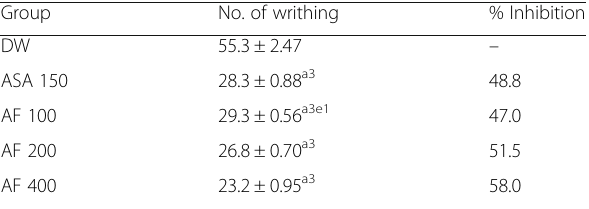
Table 4 Effect of Aqueous leaves fraction of Moringa